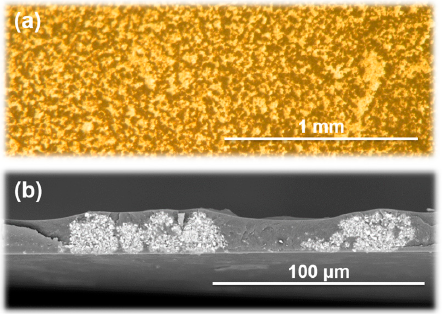
Figure 4. ( a ) Optical microscopic photographs; and ( b ) cross-sectional SEM image of BMI/BPADA- MPD blend films containing n-ZnO particles (7 vol %).